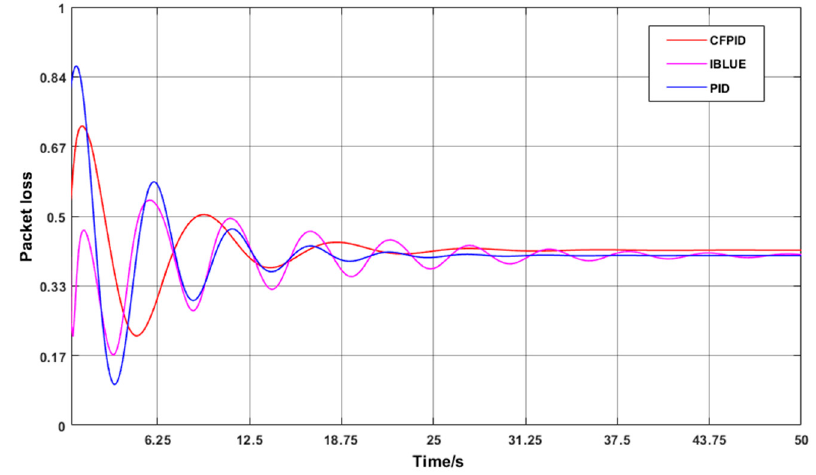
Figure 9. Two-hundred node-time packet loss rate curve.